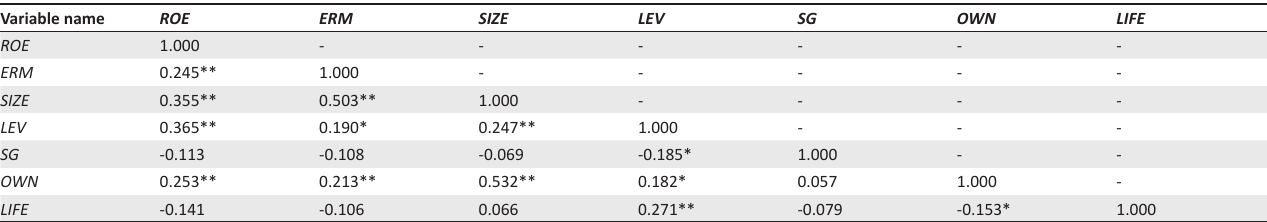
TABLE 2: Pearson correlation